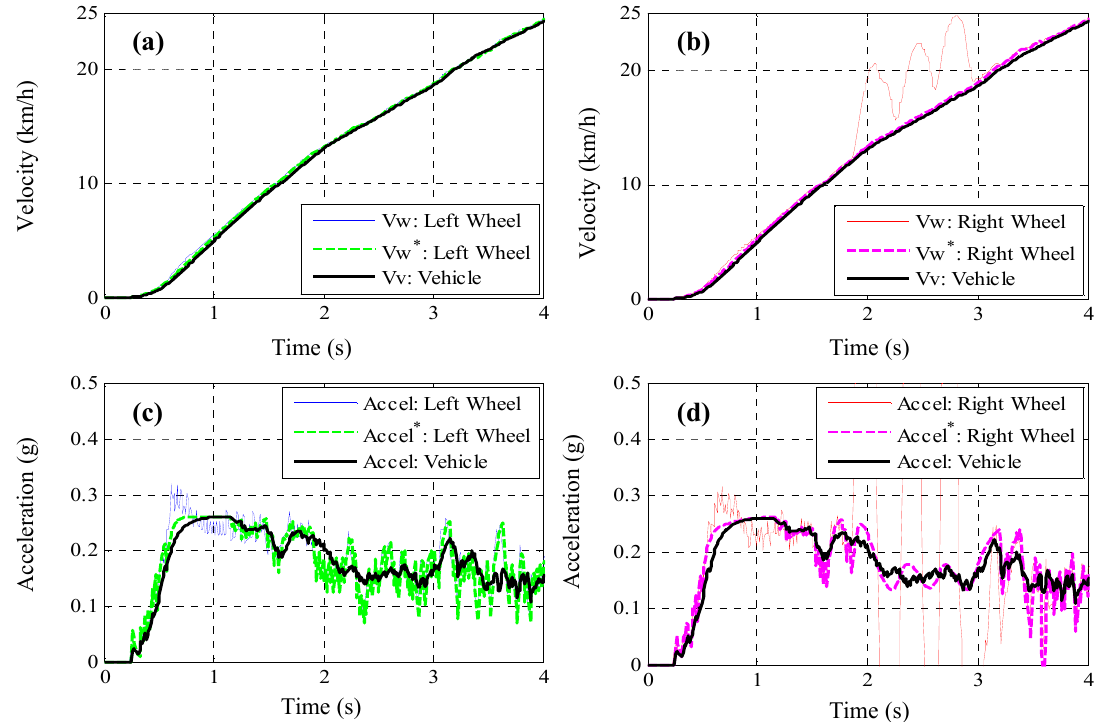
Figure 11. Experimental results for vehicle velocity estimation: ( a ) Left wheel velocity; ( b ) Right wheel velocity; ( c ) Left wheel acceleration; ( d ) Right wheel